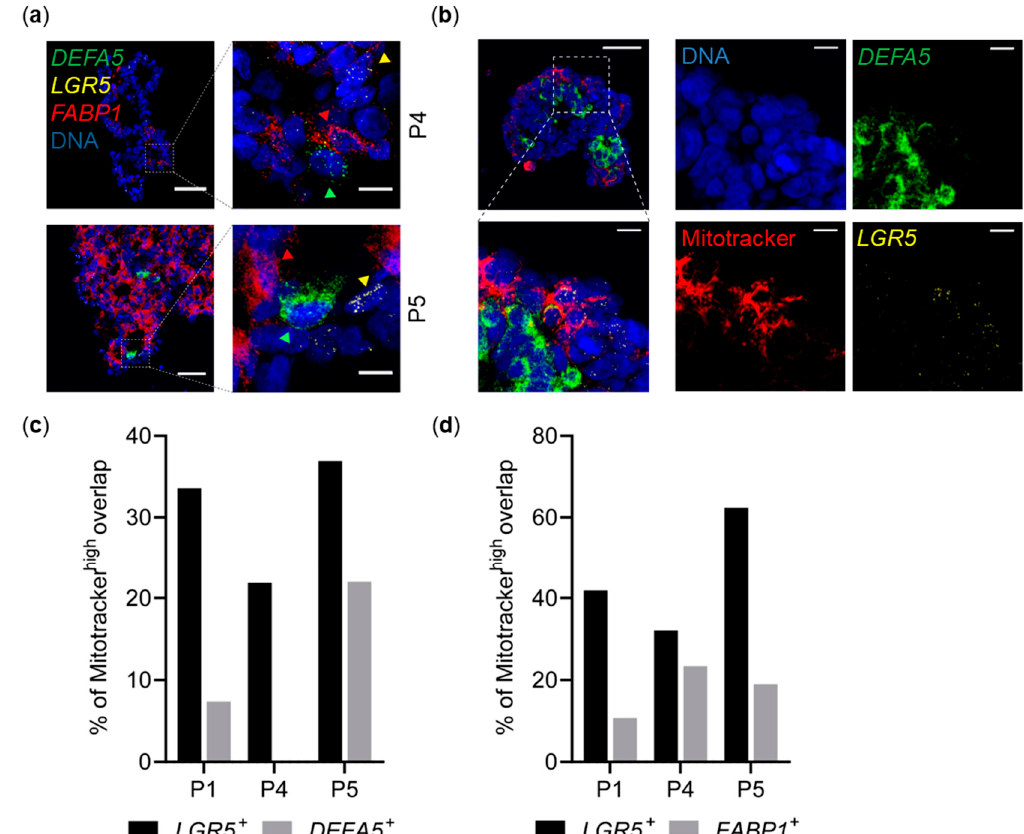
Figure 4. Spatial distribution of metabolic activity and distinct cell types in individual colorectal cancer (CRC) spheroids. ( a ) Histological sections of CRC spheroids co-stained for representative lineage-specific marker genes by RNA fluorescence in situ hybridization (FISH). Left: Overview images. Scale bar, 50 μ m. Right: Magnified images representing dashed box regions in overview images (4× digital zoom). Scale bar, 10 μ m. DEFA5 : Paneth-like, FABP1 : terminally differentiated-like, LGR5 : stem-like cells. Colored arrowheads mark associated subtypes in magnified images. Images represent z projections from 10 μ m slices and DNA is counterstained by 6 ′ -diamidino-2-phenylindole (DAPI). ( b ) Histological section of a spheroid (P1) stained for cell type-specific marker genes (RNA-FISH) and mitochondria (Mitotracker). Top left: Merged overview image. Scale bar, 50 μ m. Bottom left: Magnification of dashed region in top left image (4× digital zoom). Scale bar, 10 μ m. Center and right: Single channels. Scale bar, 10 μ m. Images represent z projections from 10 μ m slices and DNA is counterstained by DAPI. ( c , d ) Fraction of Mitotracker ‘ON’ cells as determined by automated image analysis pipeline. ( c ) LGR5 + or DEFA5 + cells (total number of cells analyzed: P1: n = 7379; P4: n = 2670; P5: n = 2213). ( d ) LGR5 + or FABP1 + cells (total number of cells analyzed: P1: n = 3403; P4: n = 1580; P5: n = 1601).